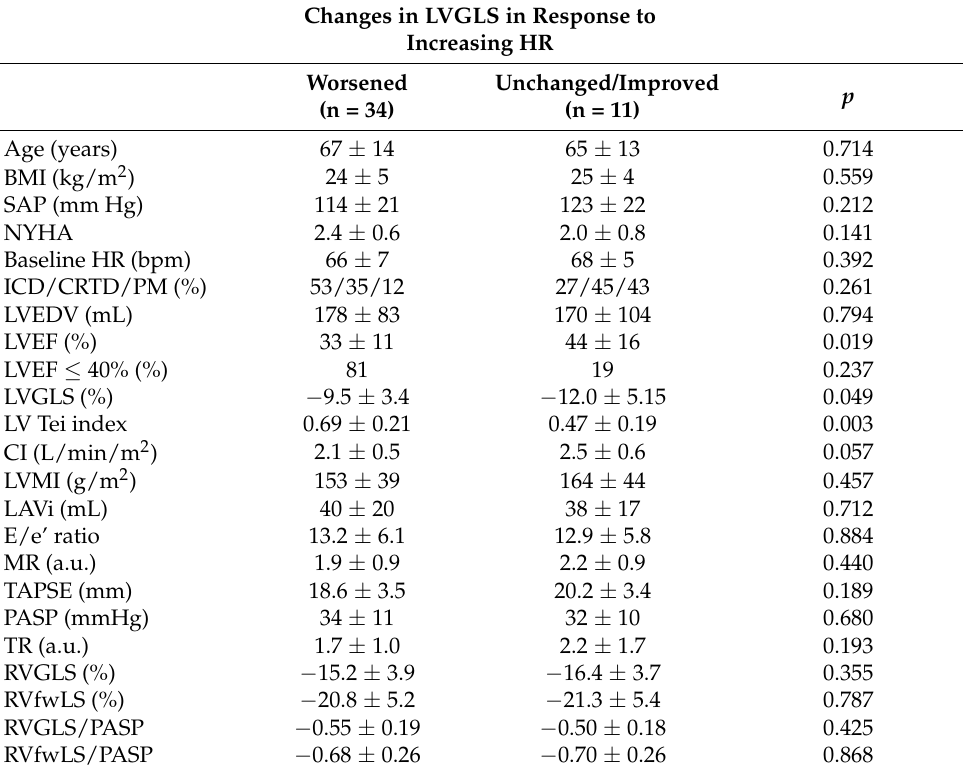
Table 2. Comparison between patients with and without HR relate worsening of LVGLS.